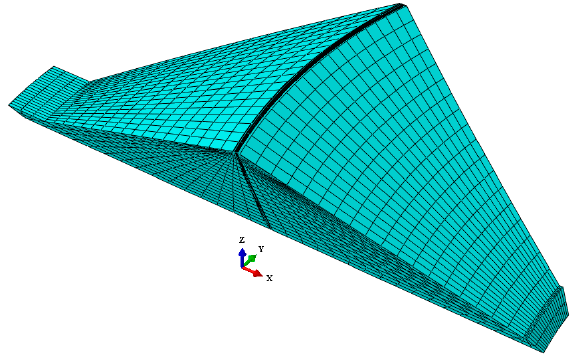
Figure 27. Meshes of FEM standard model for CACCRDs.